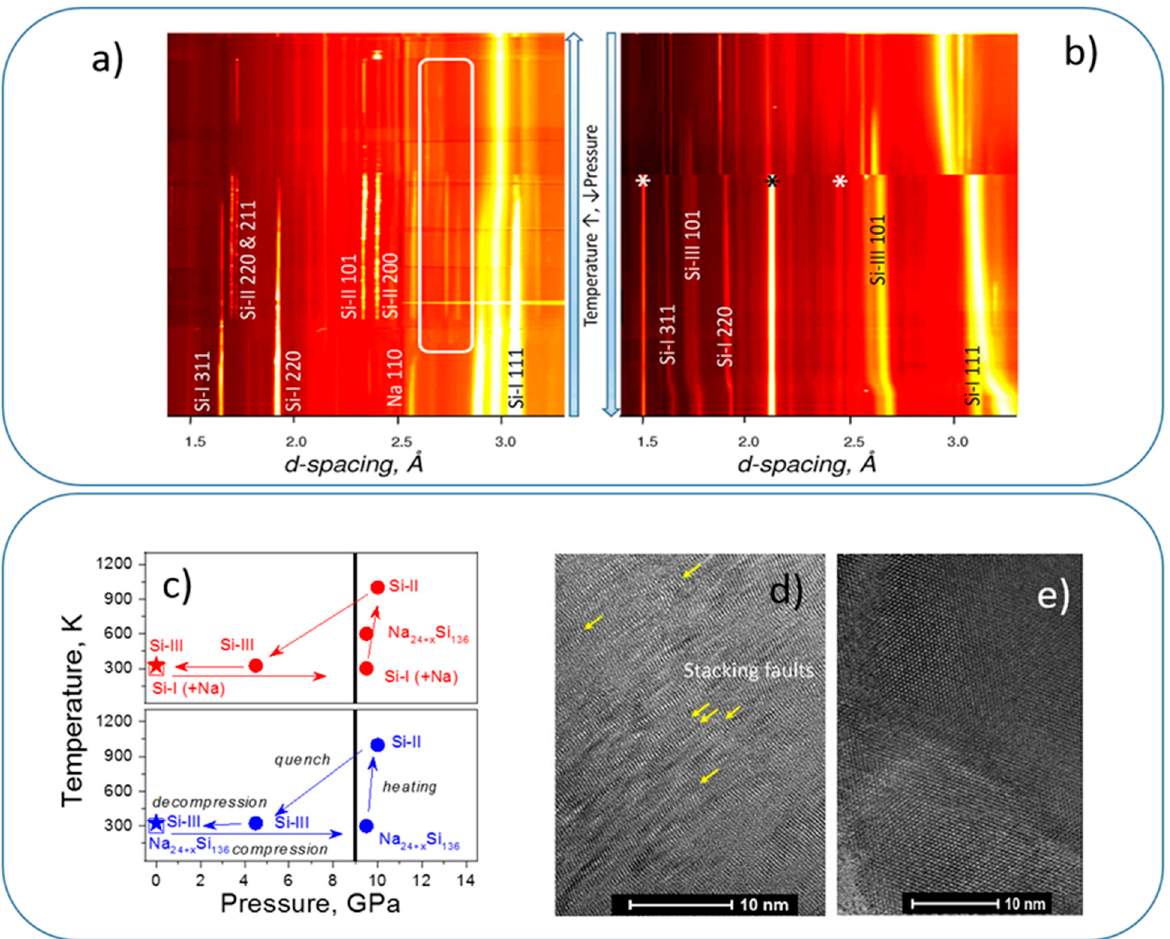
Figure 10. Sequences of XRD diffraction patterns of the Na + Si system at 9.5 GPa during ( a ) heating, and ( b ) quench and decompression using multi-anvil press (ESRF, ID06 beamline) [91]. White contour delimits the reflections that appear during interactions (Na 4 Si 4 and clathrates), asterisks show the “noise” reflections from the environment that do not move with pressure change (gasket material, etc.). ( c ) Pressure-temperature evolution during Si-III synthesis from the Na/Si mixture (red) in comparison with decomposition of Na 32 Si 136 clathrate (sII-HP) at high temperature (blue) [91]. Vertical lines indicate the low-limit pressures where Si-III has been observed and can be easily extracted in pure form. ( d , e ) TEM images of Si-III sample obtained by direct transformation at HP-HT sample ( d ) and in Na-Si system ( e ). The latter does not show stacking faults, typical for direct-transformation sample [91]. (Figure adapted with permission from [91]. Copyright 2016 American Chemical